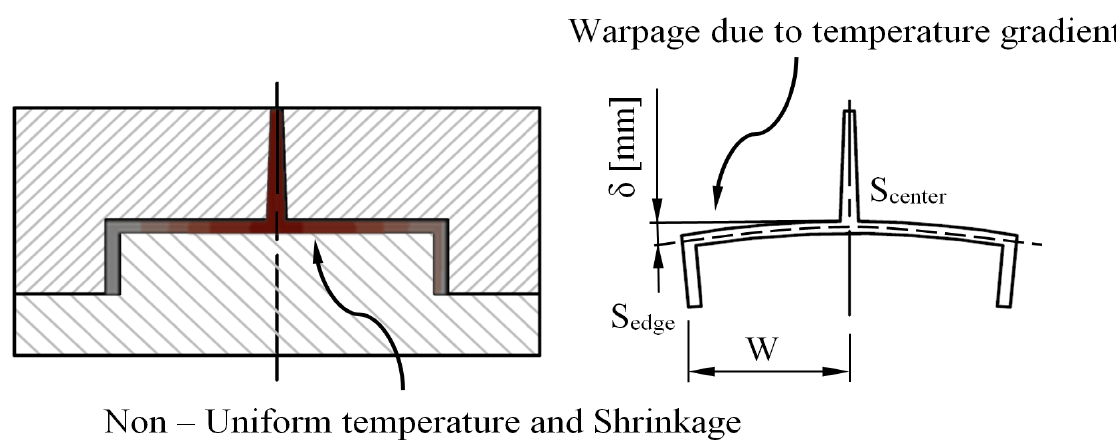
Figure 5. Warpage due to differential shrinkage of temperature gradient.